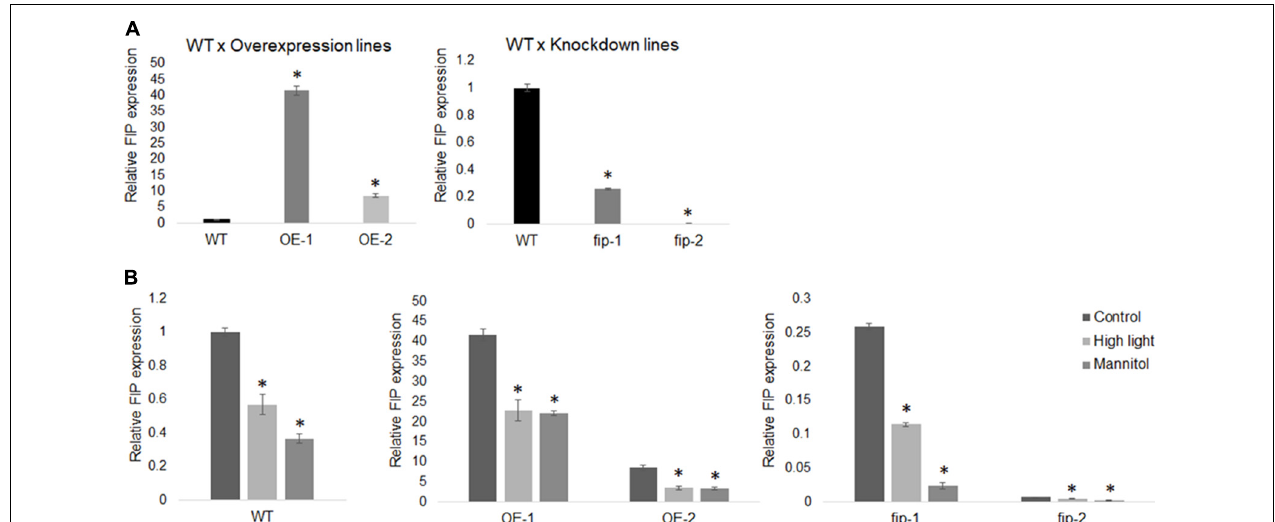
FIGURE 5 | FIP expression profile. (A) The relative transcript levels of FIP in WT plants is 1.0 when compared with the overexpression lines OE-1 and OE-2 or with the knockdown mutants fip-1 and fip-2 . (B) FIP expression is down-regulated by high light and osmotic stresses. Three-week-old plants growing under control conditions (22 ◦ C, 16 h/8 h light/dark, 120 µ mol m − 2 s − 1 ) were submitted to a 24-h stress as follows: 400 µ mol m − 2 s − 1 (high light) or 300 mM of mannitol (osmotic stress). The relative expression was assayed by real-time RT-PCR and calculated by the (cid:49) CP method using ACTIN expression as a reference gene. Values were normalized in relation to the WT expression as 1. Data are the mean ± SD ( n = 6). Statistically significant differences are indicated by asterisks (Student’s t -test, P < 0.05) for comparisons of the OE lines and fip knockdown mutants with WT plants.